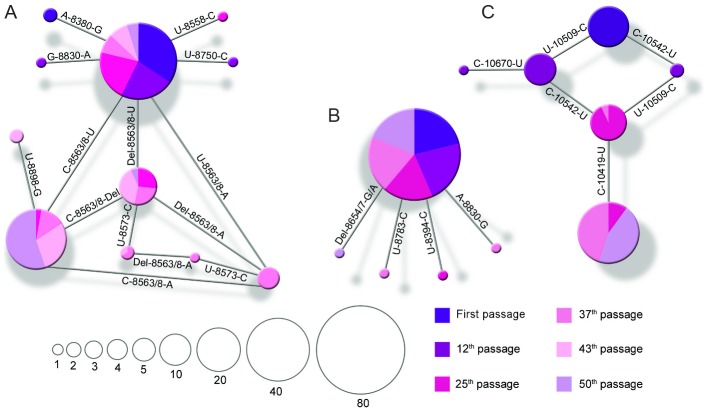
Intra-population genetic diversity of CHIKV.Minimum spanning trees were used to depict the intra-population genetic diversity of CHIKV. Each panel represents all the clones sequenced in one region of one virus passage from one method: (A) E3/E2 region of the Φnsp4 virus passaged in C6/36 cells, (B) E3/E2 region of the Φnsp1 Φnsp4 Φenv virus alternatively passaged, and (C) E1 region of the Φnsp1 Φnsp4 Φenv virus serially passaged in Vero cells. Each circle represents one variant and its size corresponds to the number of clones with the same nt sequence. The original sequence is represented by the biggest circle except in panel (c) where it is the circle at the top. Mutation positions are indicated in each branch. For the point mutations, the nt present in each viral population is shown. For the 6 nt deletion found in the viruses serially passaged in C6/36 cells at nt positions 8556/61 (panel A) which was considered as a unique event, (i) the word ‘Del’ indicates that it is present in the nearest viral population, (ii) no modification compared to the original sequence are represented by U, (iii) C and A indicate the presence of the 8566u>c and 8566u>a mutations, respectively.